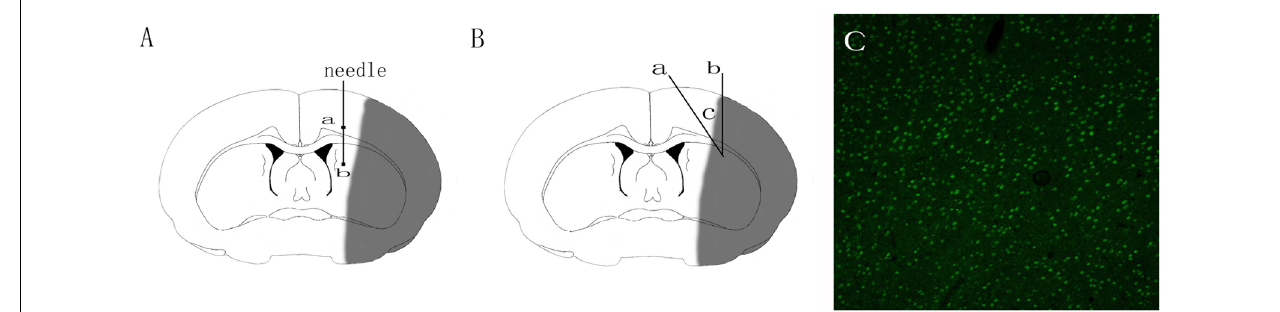
FIGURE 1 | Schematic diagram of adeno-associated virus injection and brain tissue sampling. (A) Schematic diagram of adeno-associated virus injection. Square a represents cortex injection location, Square b striatum injection location. (B) Schematic diagram of the ischemic brain. The gray area in the diagram represents the ischemic core; area c encircled by Line a and b represents the peri-ischemic region that was dissected for western-bolt, TEM and immunofluorescence analysis. (C) GFP-positive cells in the cortex 3 days after the injection of adeno-associated virus.